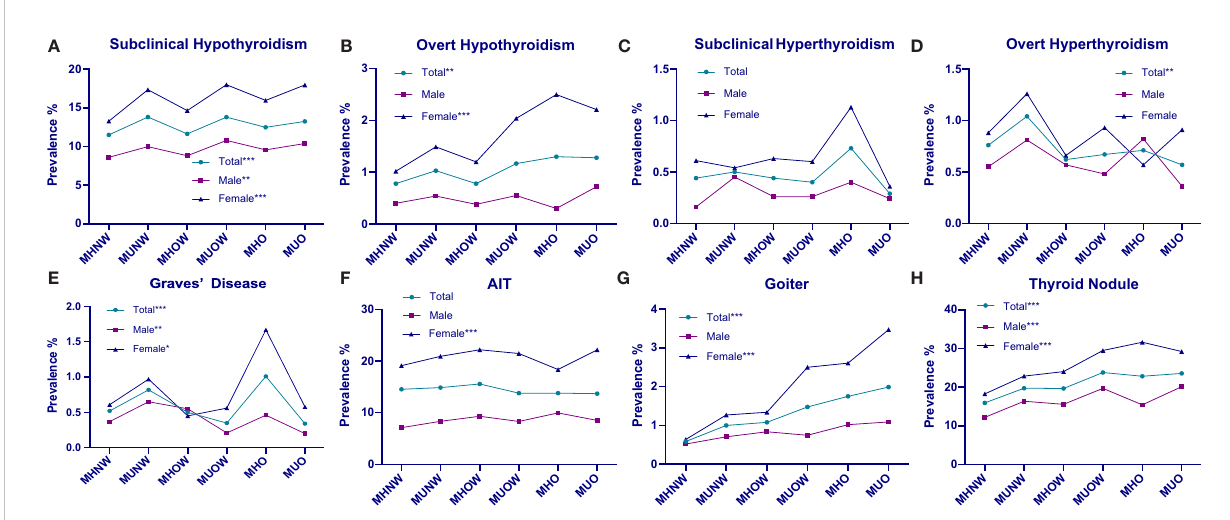
FIGURE 1 Prevalence distributions of thyroid disorders by metabolic phenotype and sex. (A) Prevalence of subclinical hypothyroidism in the overall, male, and female populations, strati fi ed by metabolic obesity phenotype. (B) Prevalence of overt hypothyroidism in the overall, male, and female population, strati fi ed by metabolic obesity phenotype. (C) Prevalence of subclinical hyperthyroidism in the overall, male, and female population, strati fi ed by metabolic obesity phenotype. (D) Prevalence of overt hyperthyroidism in the overall, male, and female population, strati fi ed by metabolic obesity phenotype. (E) Prevalence of Graves ’ disease in the overall, male, and female population, strati fi ed by metabolic obesity phenotype. (F) Prevalence of AIT in the overall, male, and female population, strati fi ed by metabolic obesity phenotype. (G) Prevalence of goiter in the overall, male, and female population, strati fi ed by metabolic obesity phenotype. (H) Prevalence of thyroid nodule in the ove rall, male, and female population, strati fi ed by metabolic obesity phenotype. * P < 0.05 for trend. ** P < 0.01for trend. *** P < 0.001 for